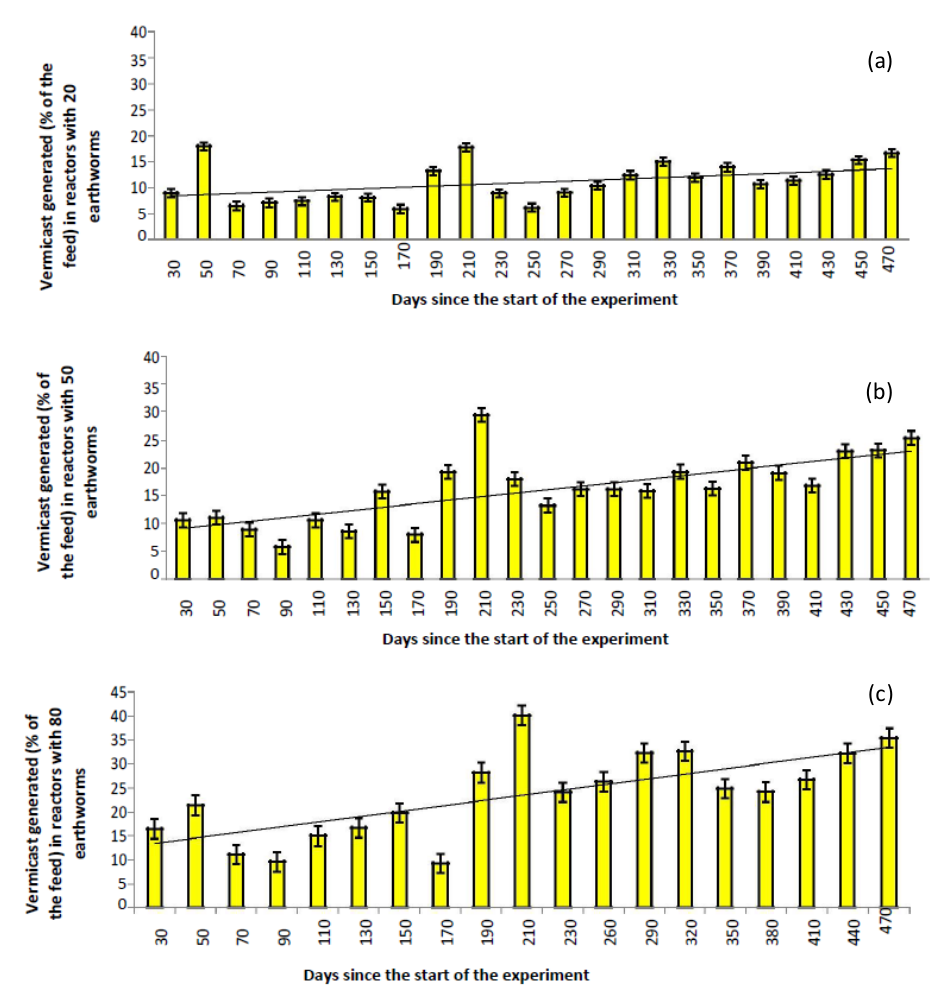
Figure 3. Trend in the generation of vermicast as a function of time in pulse-fed, semi-continuous reactors operated with ( a ) 20, ( b )50, and ( c ) 80 earthworms with fresh Parthenium.